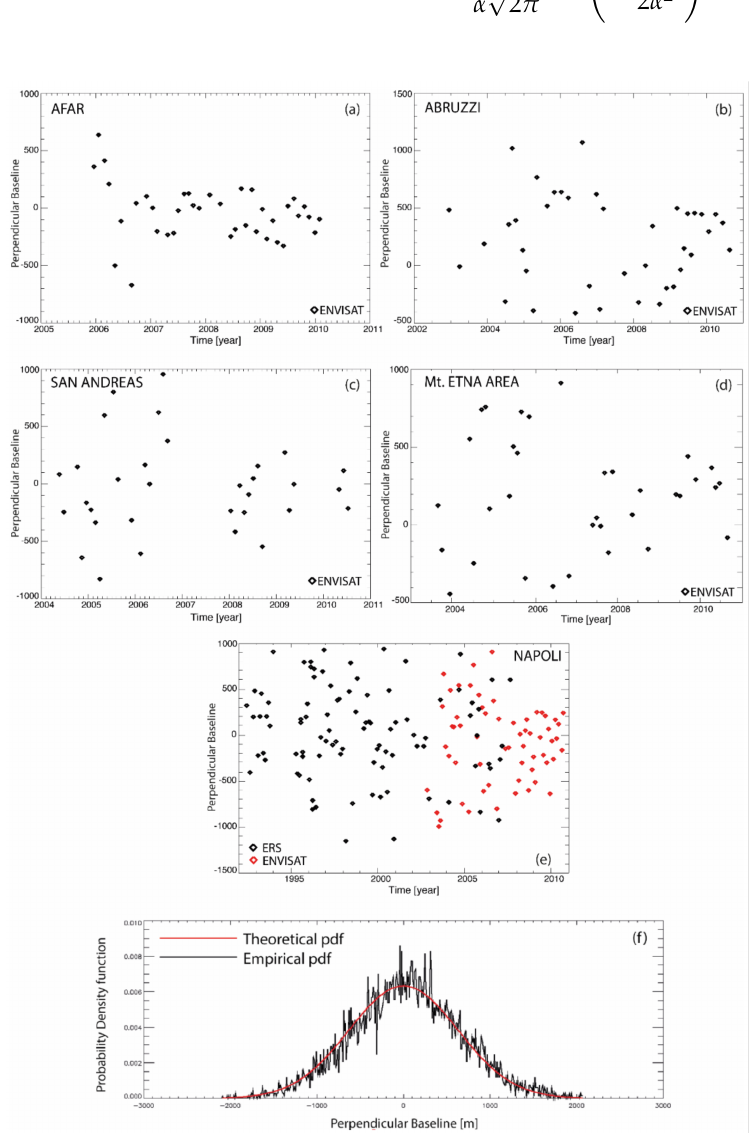
Figure 4. Study of the perpendicular baseline distribution of sets of SAR images collected by the first-generation SAR sensors. ( a – e ) Representation in the temporal/perpendicular baseline plane of relevant sets of SAR data acquired by the ERS and ENVISAT sensors on the five selected test-site areas of Afar, Ethiopia, Abruzzi, Central Italy, San Andreas Fault region, U.S., the Mt. Etna zone, Sicily Island, and the metropolitan area of the city of Naples in Italy. The data span the time interval between 1992 and 2010. ( f ) Theoretical density probability function (pdf) (red line) and the empirical (black line) density probability function of the whole potential set of interferometric perpendicular baselines. Note that the theoretical pdf is drawn using Equation (21). In contrast, the empirical pdf is computed by the data by merely drawing the (normalized) histogram of the SAR dataset interferometric perpendicular baselines, see [58] for details on the probability distribution function of a random